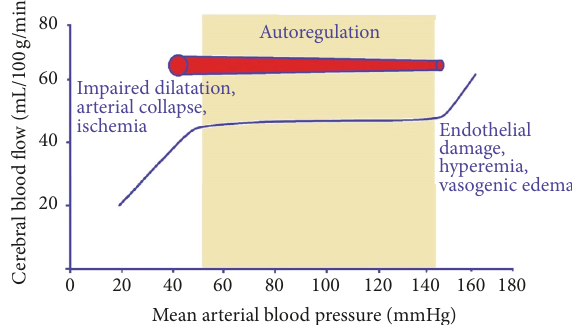
Figure 2: (Not to scale) Cerebral Autoregulation Curve. Autoreg- ulation ensures nearly constant CBF despite changes in perfusion pressure over a certain range ( ∼ 50–150 mmHg). In healthy brain over 150mmHg there is endothelial damage, leading to impaired vessel reactivity resulting in hyperemia, vasogenic edema, and intracranial hypertension. Under 50 mmHg CBF becomes directly proportional to perfusion pressure with risk of arterial collapse and